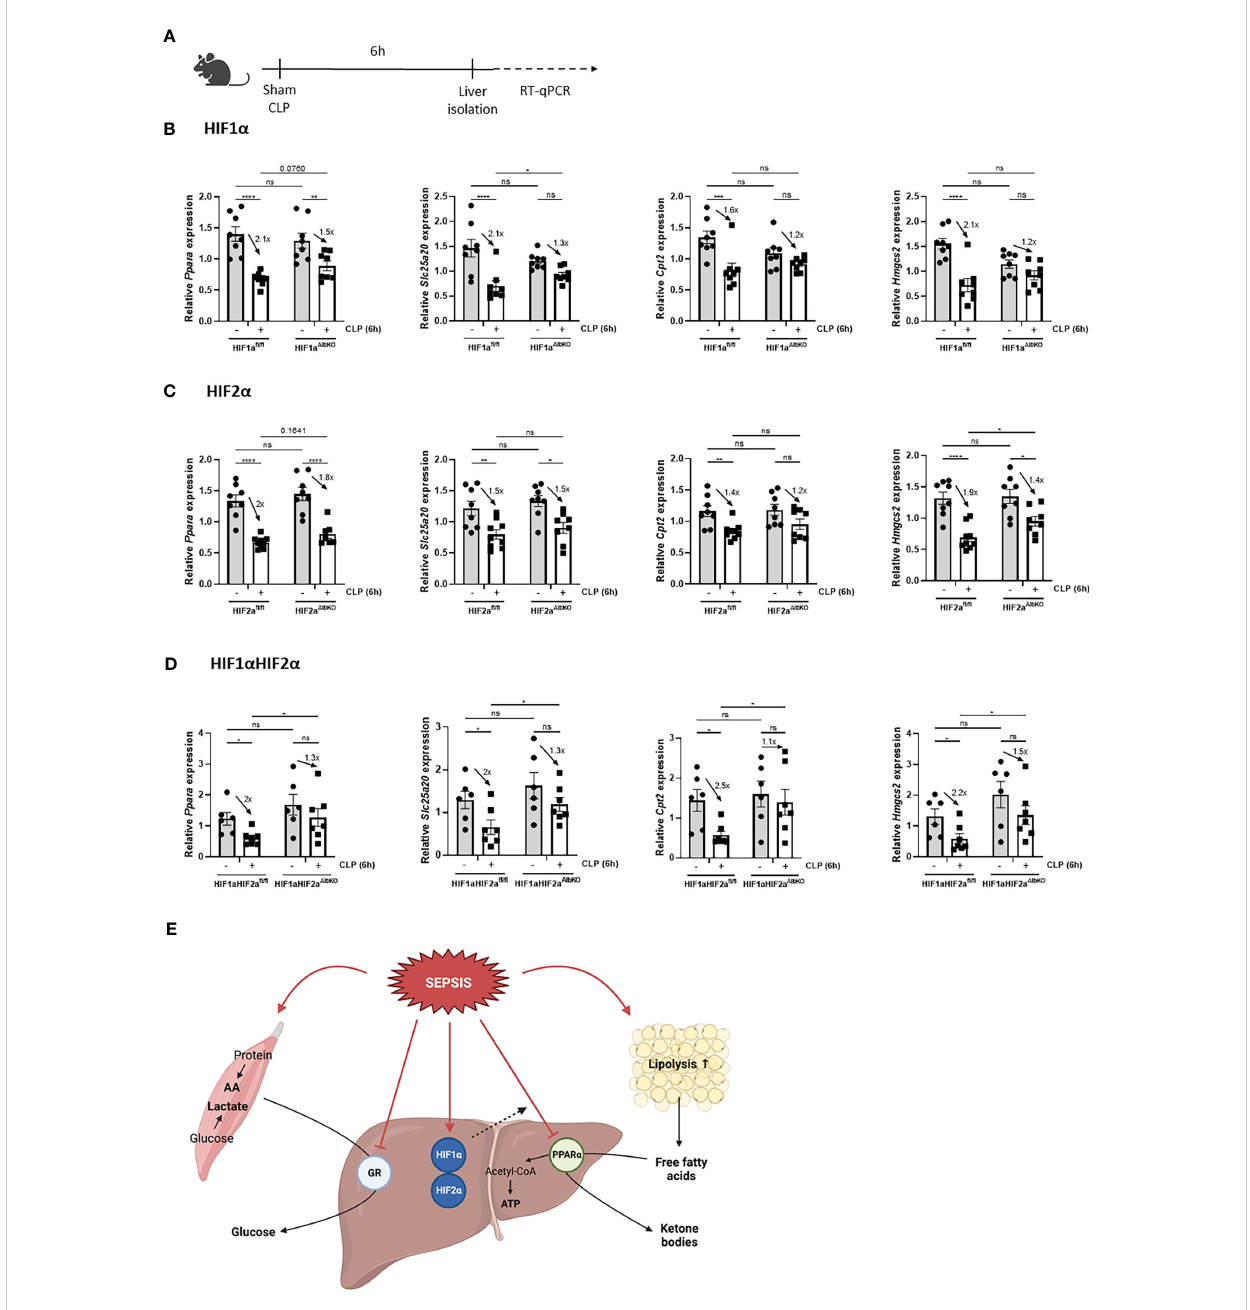
FIGURE 7 Absence of HIF1 a in hepatocytes might affect impaired PPAR a signaling during sepsis. HIF1a AlbKO , HIF2a AlbKO or HIF1aHIF2a AlbKO mice and wild-type littermates were randomly assigned to a sham or CLP procedure. 6h post-surgery, livers were isolated. (A) Experimental set-up. (B-D) The expression levels of Ppara and PPAR a responsive genes were measured in the liver of HIF1a AlbKO (n=8/group) (B) , HIF2a AlbKO (n=8-9/group) (C) , or HIF1aHIF2a AlbKO (n=6-7/group) (D) mice and wild-type littermates via RT-qPCR. (E) Graphical abstract. Fold inductions are displayed on the graphs. All bars represent mean ± SEM. P-values were analyzed with two-way ANOVA. ****P < 0.0001, ***P < 0.001, **P < 0.01, *P ≤ 0.05. ns, non- signi fi